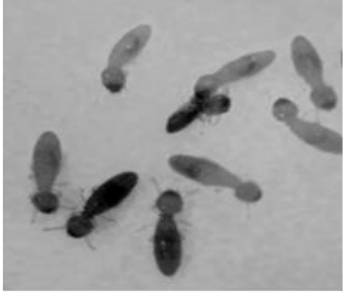
Figure 1. Placing blue vector termites (dark termites) among healthy termites (white